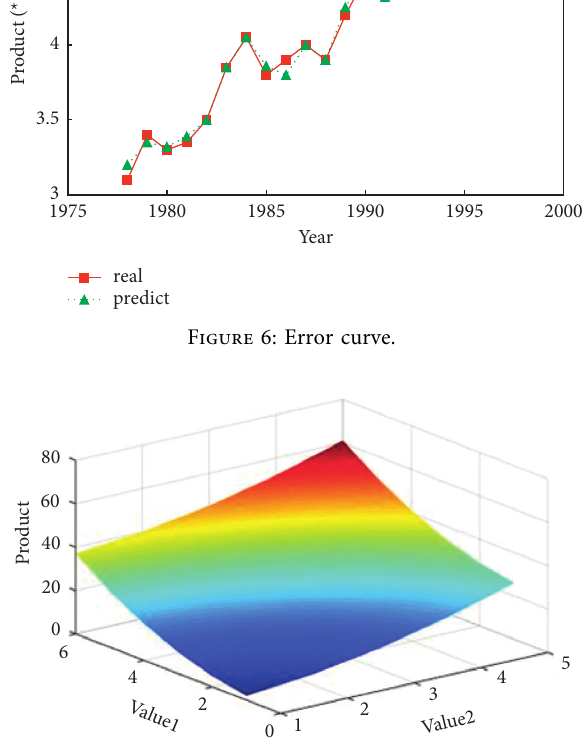
Figure 7: Regression prediction.